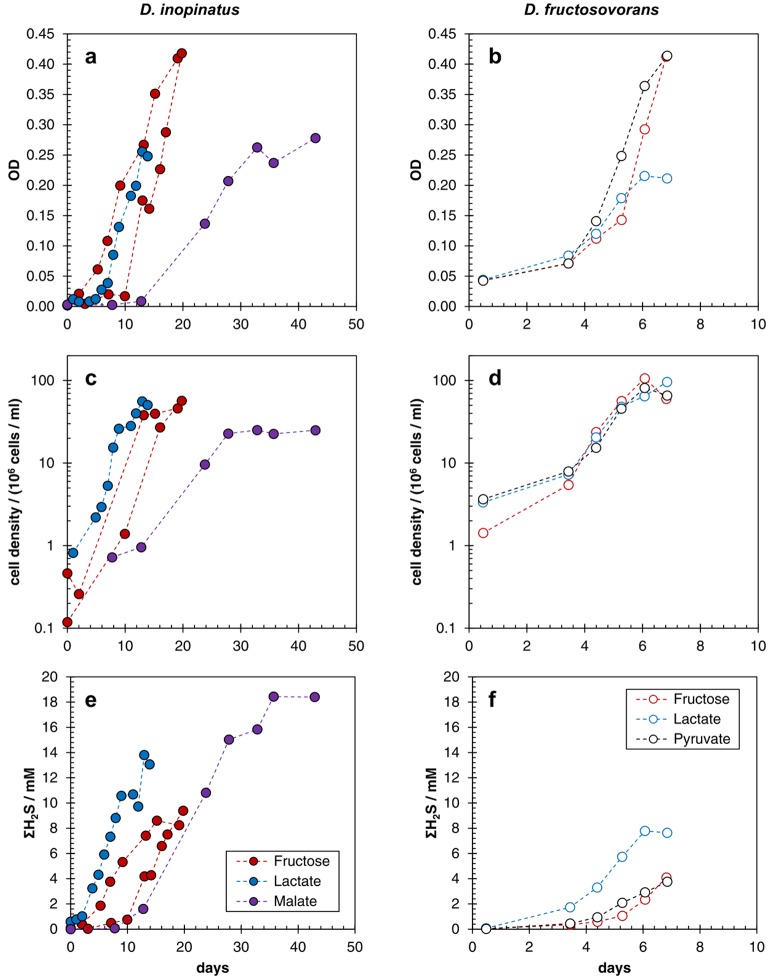
Growth curves showing optical density of cultures (a,b), cell densities determined by epifluorescence microscopy (c,d), and total sulfide (ΣH2S) concentration (e,f) in batch cultures of D. inopinatus (left) and D. fructosovorans (right) grown on different organic substrates (see the legend for the explanation of color coding) in phosphate-replete (>1000 μM) media. Data are from Table 2. Note the difference in scales for the time axis between left and right panels. The uncertainties in cell density and sulfide concentration, respectively, were ±15% and ±10%, respectively.